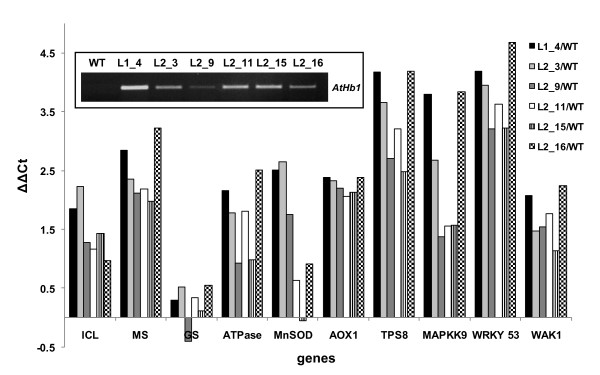
Transcript ratios of AtHb1-induced marker genes in different AtHb1-overexpressing lines relative to WT. AtHb1 transcript accumulation in siliques of different transgenic lines obtained by RT-PCR is depicted in the inset. For transcript analysis siliques of 45 DAG plants have been used. qRT-PCR analysis was conducted for genes showing a preferential expression in AtHb1 (Line 1-1) compared to WT under control conditions as measured by microarray analysis. MnSOD (At3g56350), ICL (At3g21720), MS (At5g03860), AOX1 (At1g32350), WAK1 (At1g21250), GS (At5g53460.), ATPase (Chl) (At1g15700 ), TPS8 (At1g70290), MAPKK9 (At1g73500), WRKY 53 (At4g23810).